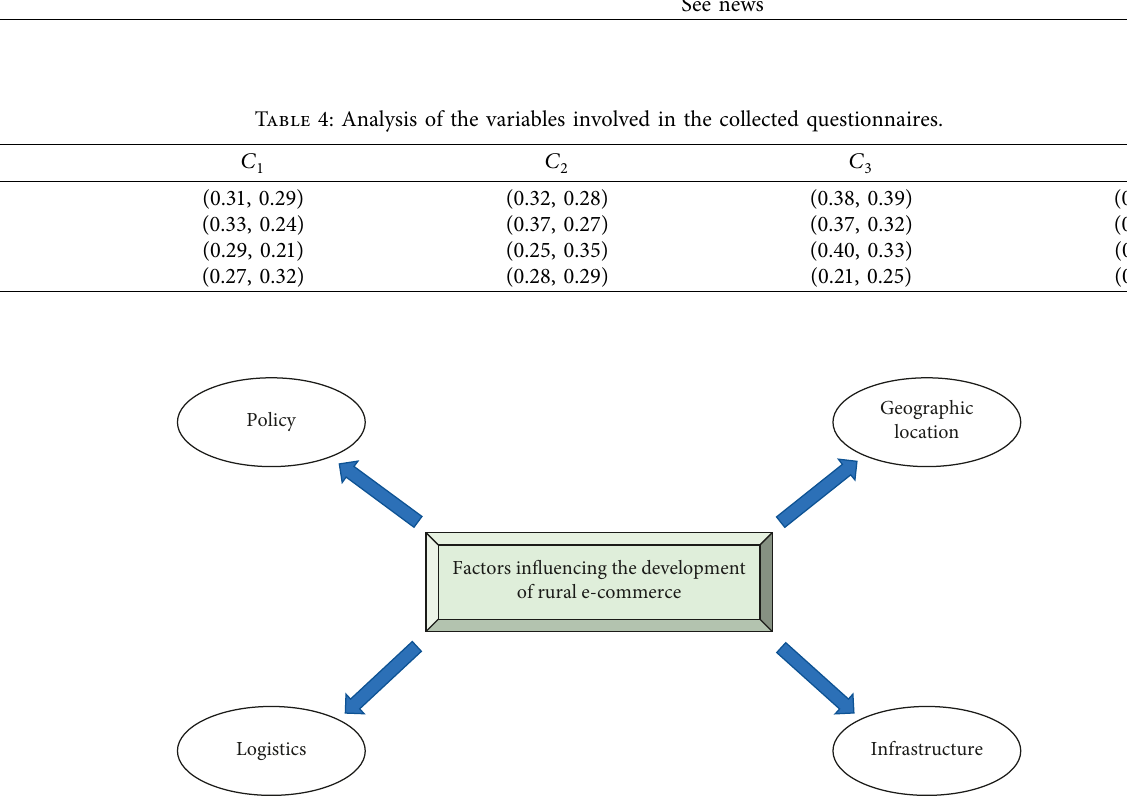
Figure 6: Factors influencing the development of rural